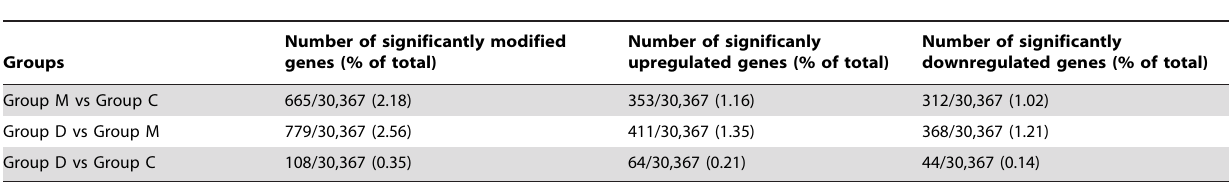
Table 3. Number of genes that were modified 6 2 folds (up- or downregulation) in different experimental groups.